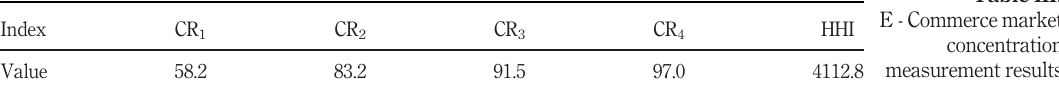
Table III. E - Commerce